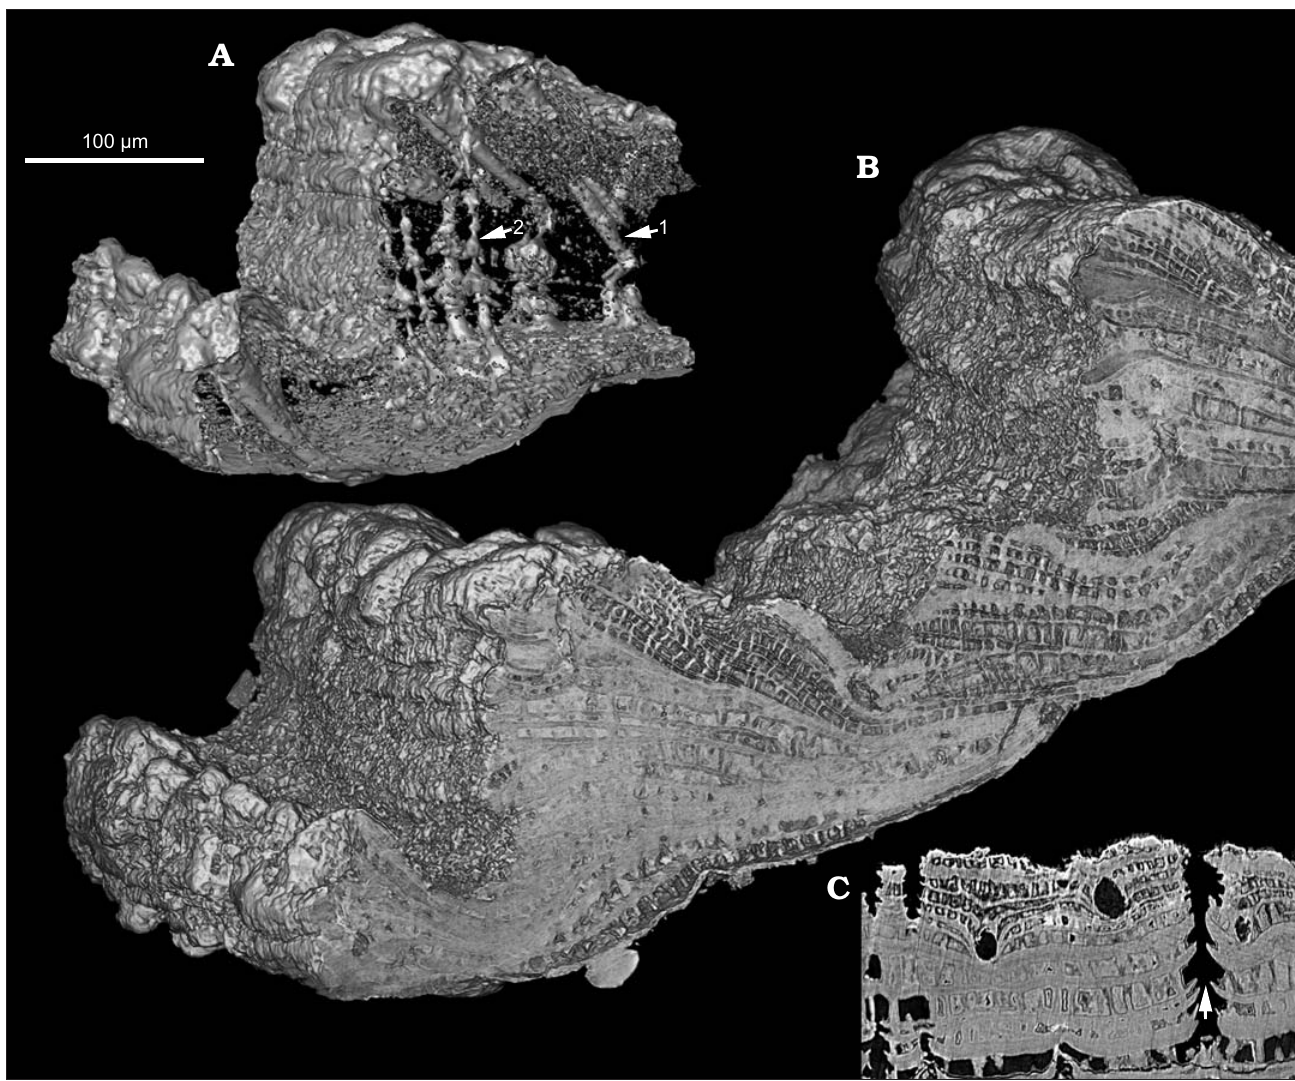
Fig. 2. Stem-group brachiopod Oymurania gravestocki Ushatinskaya in Kouchinsky et al., 2015 (SMNH X5302) from the lower Cambrian Perekhod Formation, Achchagyi-Kyyry-Taas section, Siberia. SRXTM volumetric renderings (A, B) and slice (C) through the distal part of an older shell. A . Inter- secting systems of canals inside the wall fragment ( B ); note the tangential (setigerous) canals with closed inner terminations (arrow 1) and the perpendicular Micrina – Setatella type canals (arrow 2). C . Virtual slice through the same specimen showing rounded cross-sections of tangential (setigerous) canals and vertically oriented Micrina – Setatella type canals with laminae adjacent to the canals deflected towards the outer shell surface